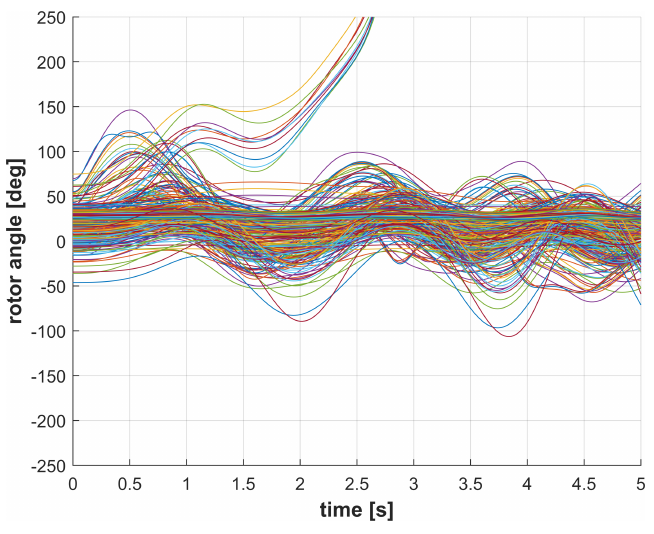
Figure 7. Rotor angles in the uncontrolled case.